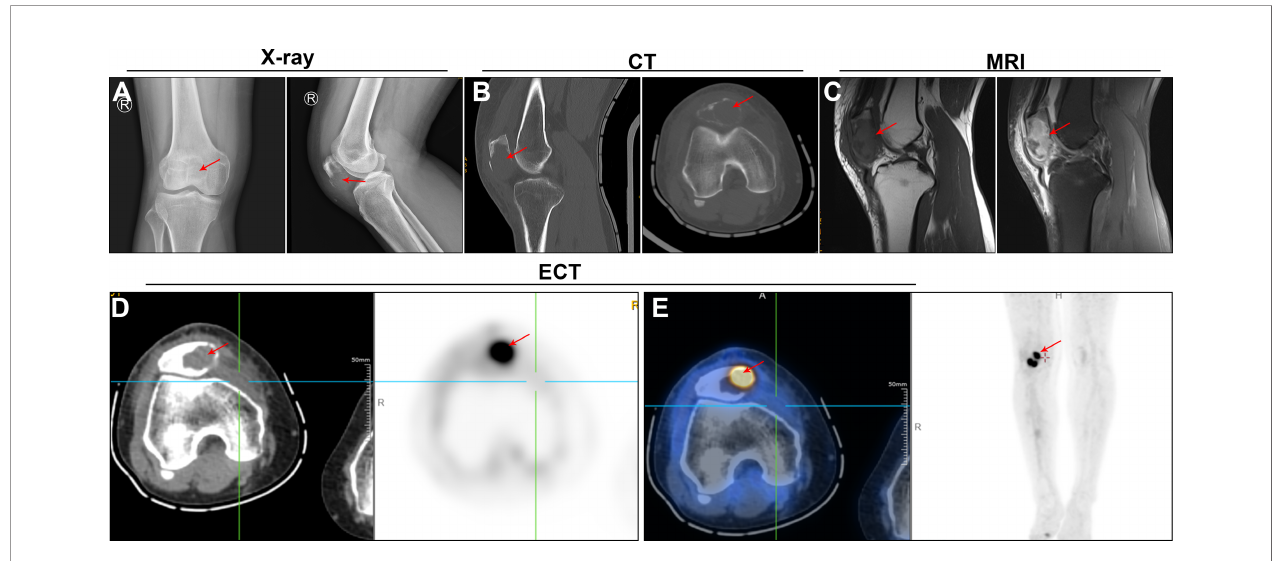
FIGURE 1 | Imaging views of the knee. (A) Anterior and lateral X-ray views showed the osteolytic changes (red arrows) in the patella. (B) Sagittal and transverse computed tomography (CT) images showed the decreased bone density (red arrows) in the patella, and tumor involvement inside the whole patella. (C) Sagittal magnetic resonance imaging (MRI) revealed a low signal in the T1-weighted image and a high signal in fat-suppressed T2-weighted image (red arrows). (D , E) Positron emission tomography-computed tomography (PET/CT) showed extremely intense focal uptake in the right knee joint and no focal uptake in other